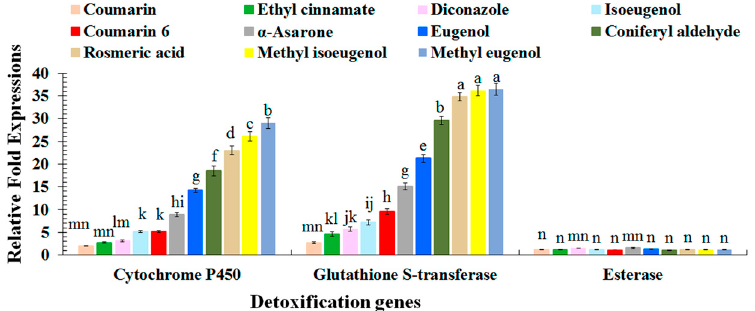
Figure 2. Expression pattern of detoxification genes of red palm weevil larval midguts in response to different phenylpropanoids by qRT-PCR. Bars (means ± SE) followed by different letters are significantly different (Fisher’s LSD test, α =